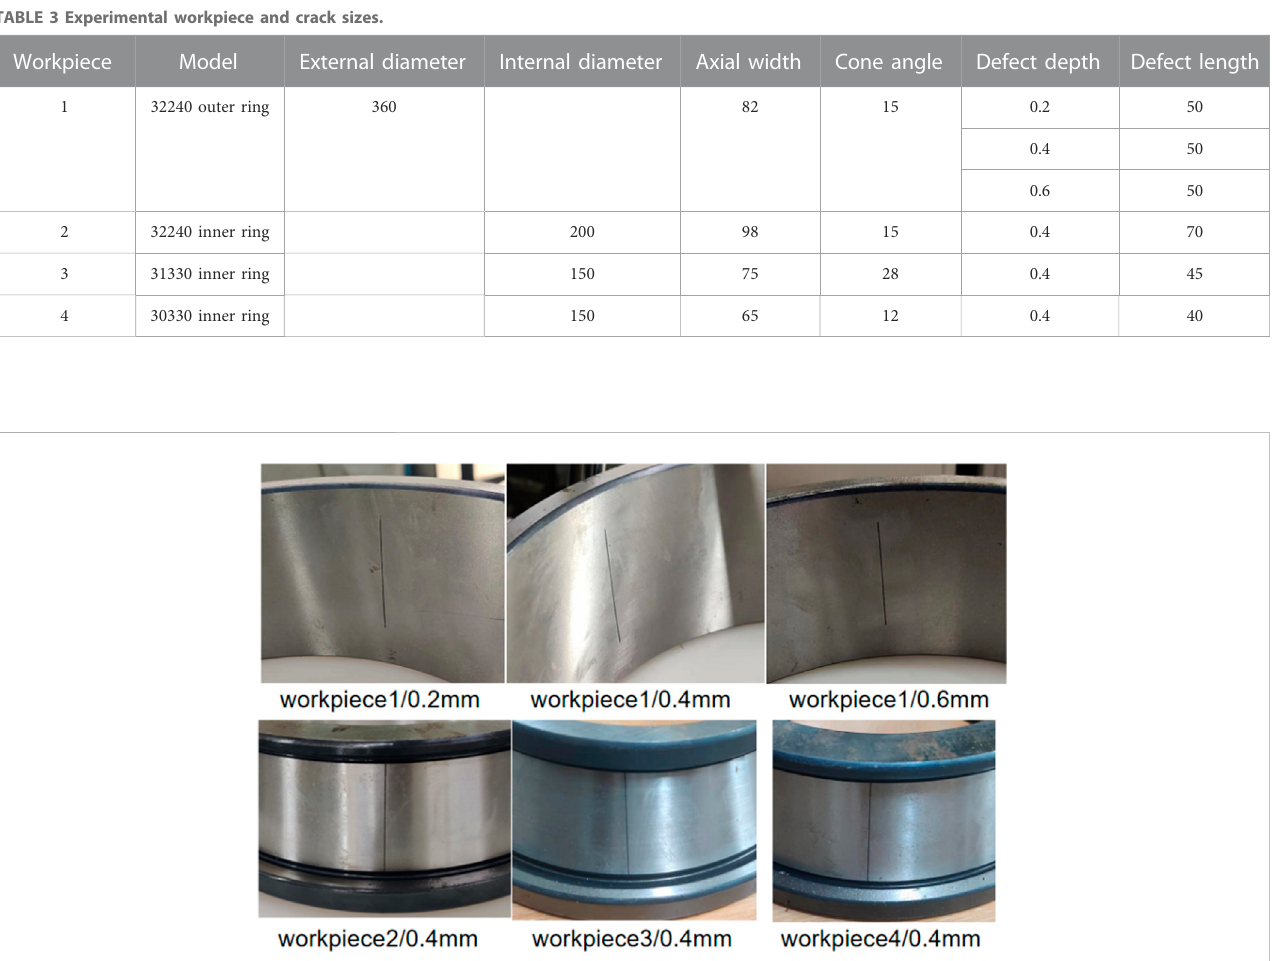
FIGURE 11 Experimental workpieces and arti fi cial axial